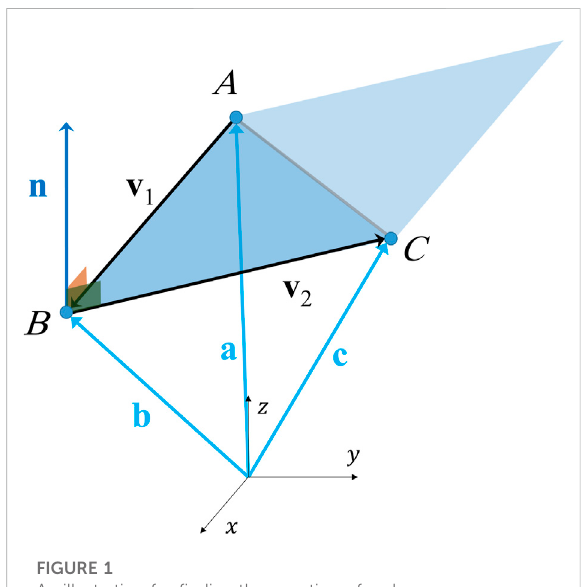
FIGURE 1 An illustration for fi nding the equation of a